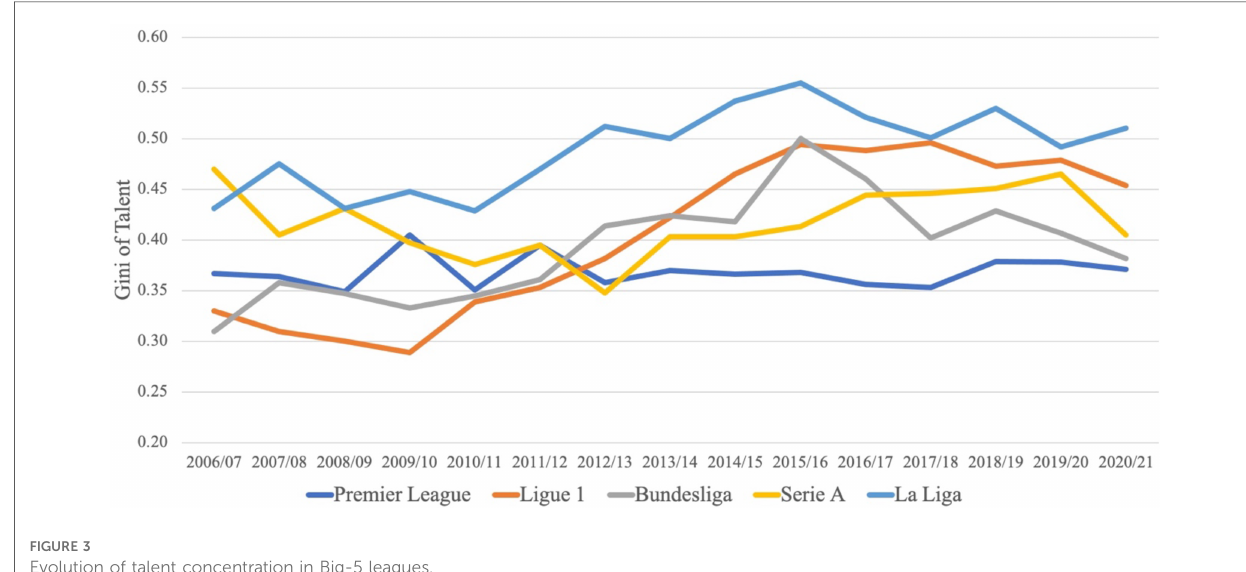
FIGURE 3 Evolution of talent concentration in Big-5 leagues.